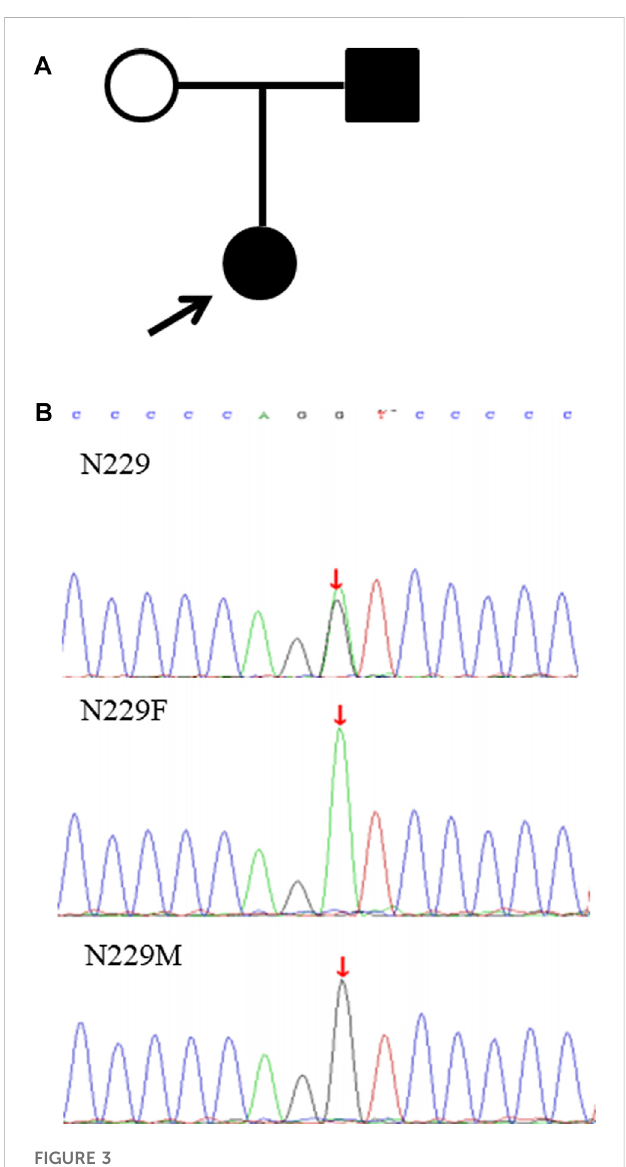
FIGURE 3 Pedigree chart and veri fi cation of the variant in COL4A5 in the N229 family. (A) Pedigree chart of the N229 family; (B) the variant c.4352G > A in COL4A5 validated by Sanger sequencing in the proband (N229), father (N229F), and mother